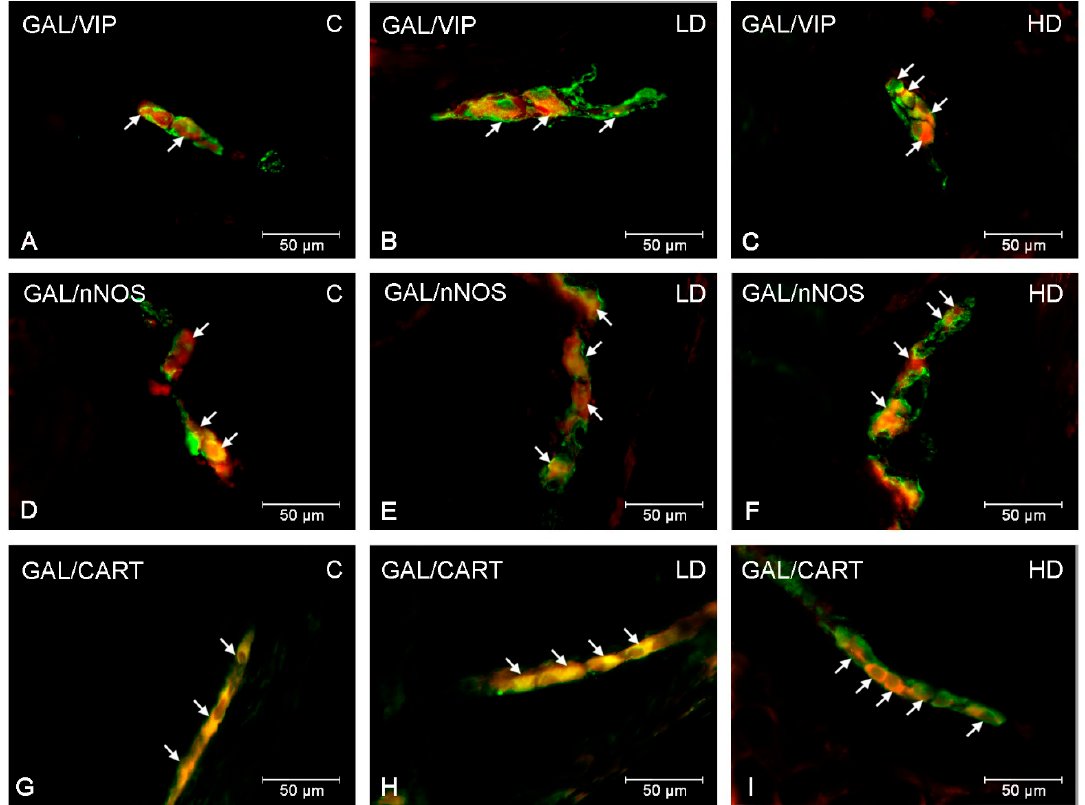
Figure 4. Co-localization of GAL with VIP, nNOS and CART in submucous plexuses in the porcine stomach. The most representative images showing changes in the degree of co-localization of GAL with VIP in the submucous plexuses of the corpus ( A,B,C ); GAL with nNOS in the submucous plexuses of the cardia ( D,E,F ); GAL with CART in the submucous plexuses of the cardia ( G,H,I ). Photographs A, D, G showing submucous plexuses in the physiological conditions; B, E, H—after low and C, F, I after high doses of acrylamide administration. All photographs have been created by digital superimposition of two color channels (green for GAL and red for VIP, nNOS and CART respectively). Neurons immunoreactive to GAL and VIP or nNOS or CART are indicated with arrows.